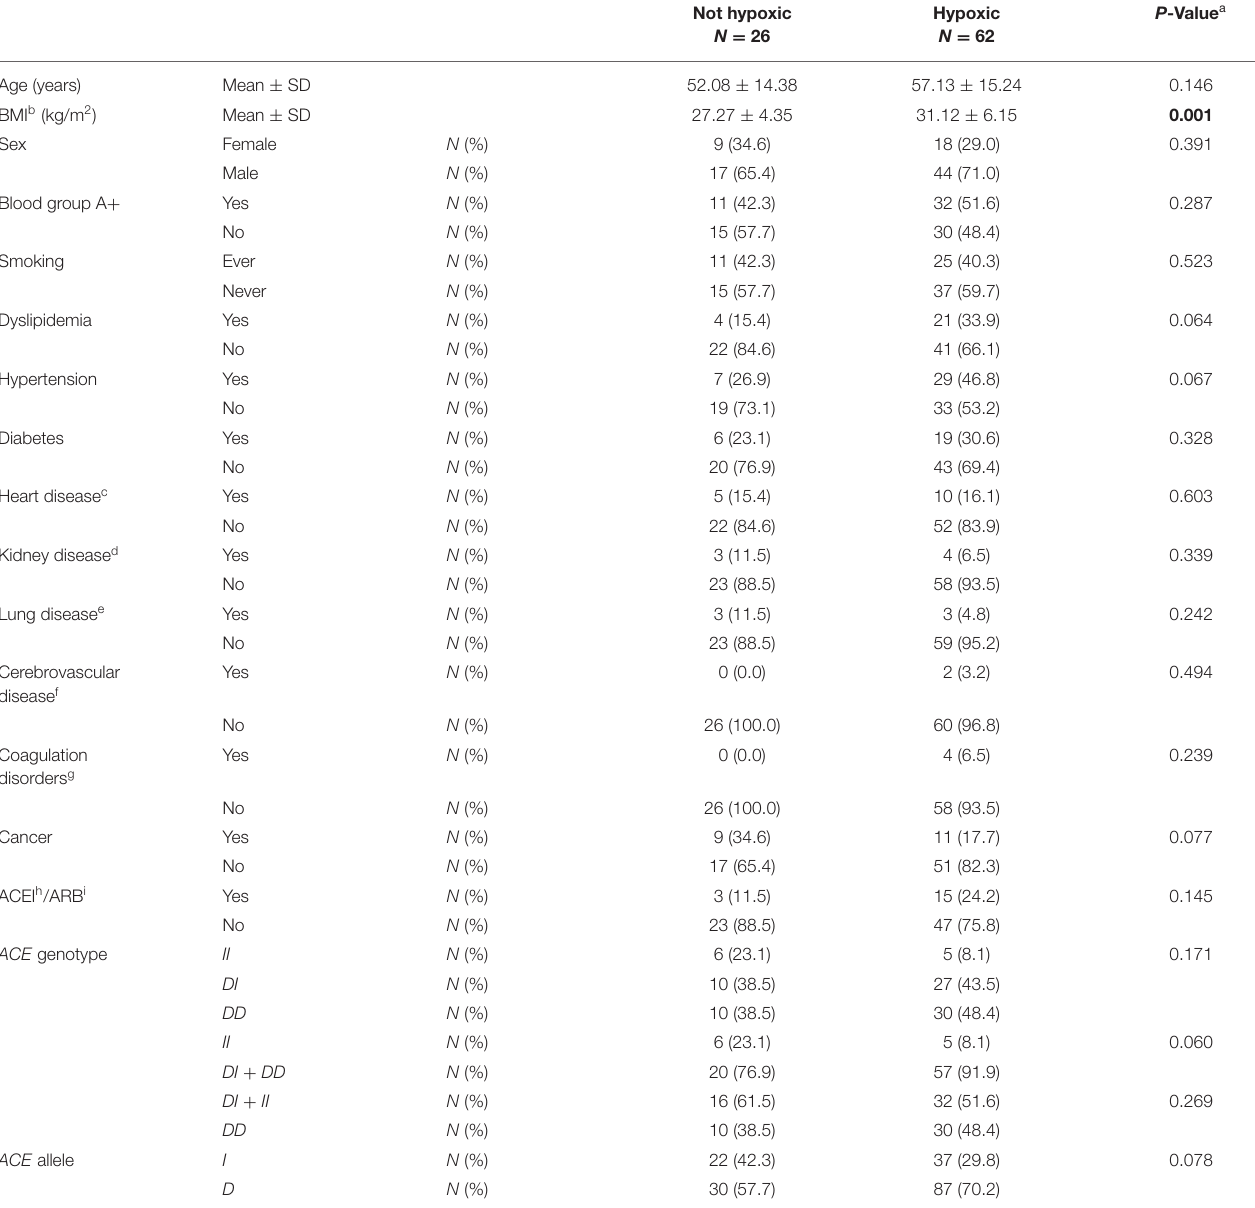
TABLE 4 | Association between baseline characteristics and ACE1 polymorphism with hypoxic vs. non-hypoxic hospitalized COVID-19 cases.